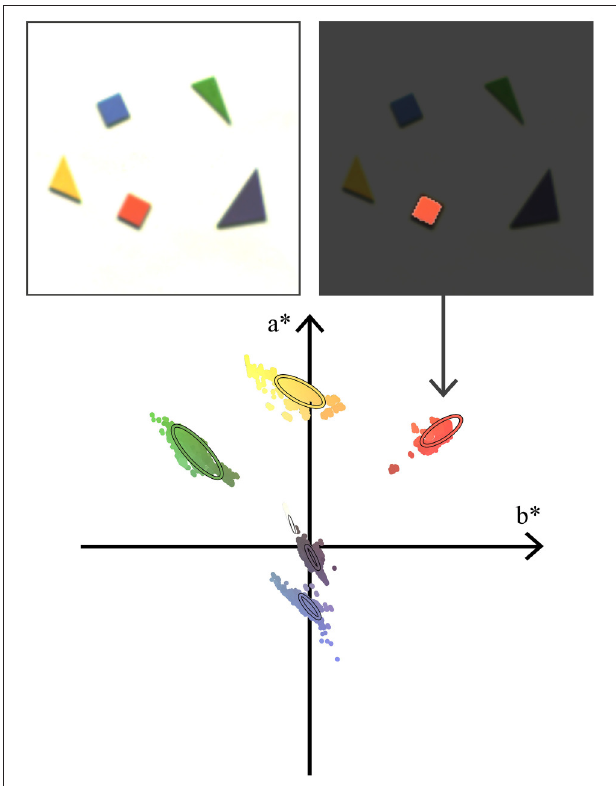
FIGURE 6 | In order to build color signatures for a set of wooden pieces, we accumulate noise-generated events from a static scene. We use the resulting image to build a mask labeling a specific piece (here, the orange one). All the color events associated with the mask’s pixels are converted to the CIEL*a*b* space and projected on the a*b* plane. The projected points are used to estimate a bivariate normal distribution, which we call the signature. The bottom diagram shows 95% confidence ellipses of the wooden pieces’ signatures in the a*b*